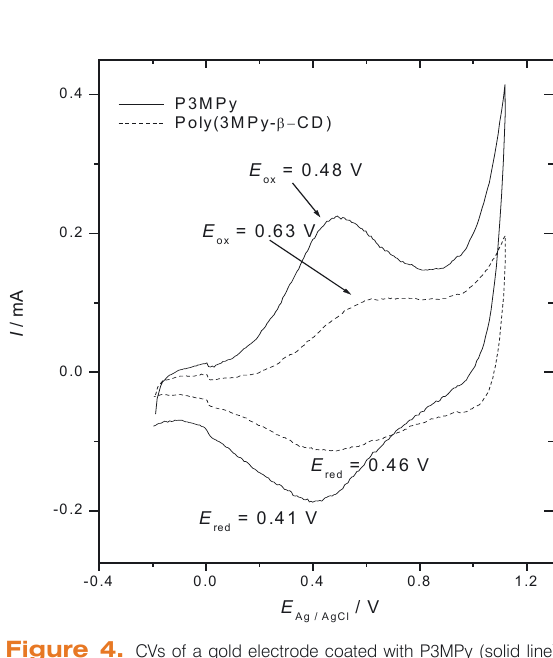
Figure 4. CVs of a gold electrode coated with P3MPy (solid line) and poly(3MPy- β -DMCD), (dashed line) in a blank solu- tion of acetonitrile + 0.05 M LiClO , d E /d t = 50 mV·s -1 4